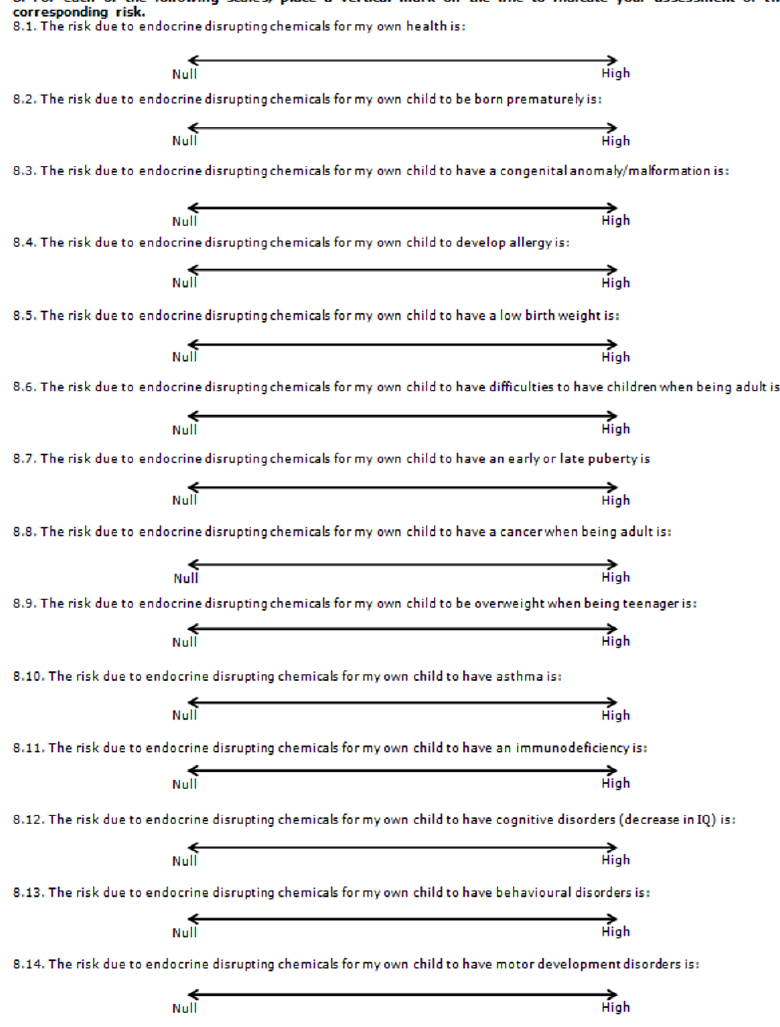
Figure A2. Items for sub-score of perceived susceptibility (translated from French).